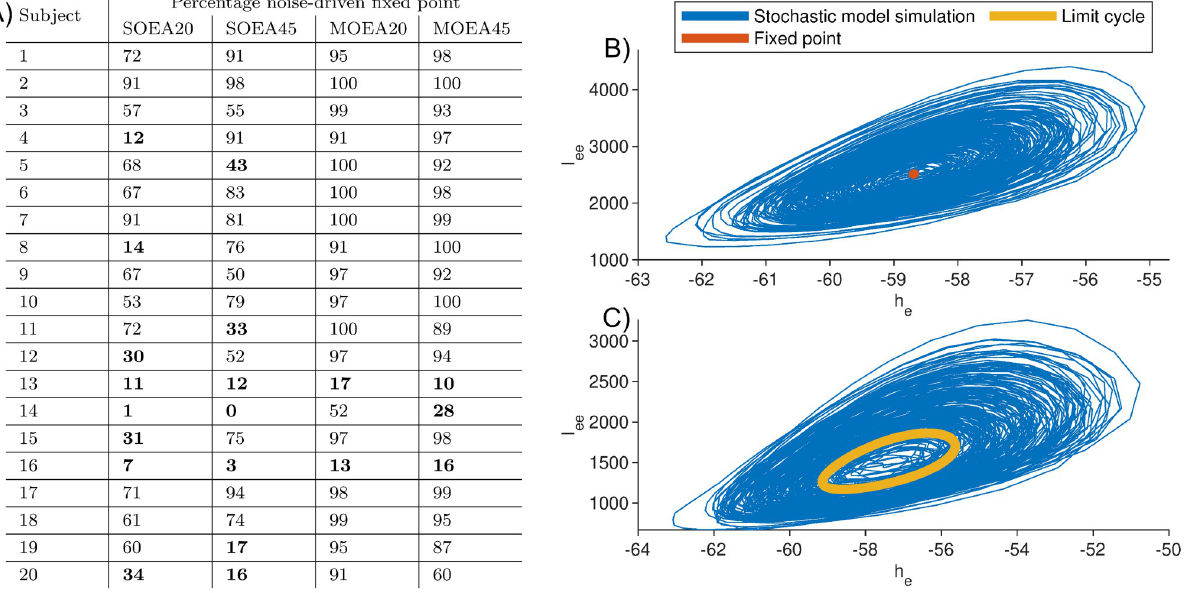
Fig 9. Comparison of the attracting state reached by model simulations. A) gives the percentage of model simulations that consisted of noise-driven fixed dynamics (as opposed to noise-driven limit cycle dynamics) for each algorithm and across all subjects. Subject-algorithm combinations that were predominantly described by noise-driven limit cycle dynamics are given in bold. B) gives an example simulation in phase space of noise-driven fixed point dynamics. Here, due to the stochasticity, the model oscillates around a stable fixed point. C) gives an example simulation in phase space of noise- driven limit cycle dynamics. In this case, the stochastic model simulations oscillate around a stable limit